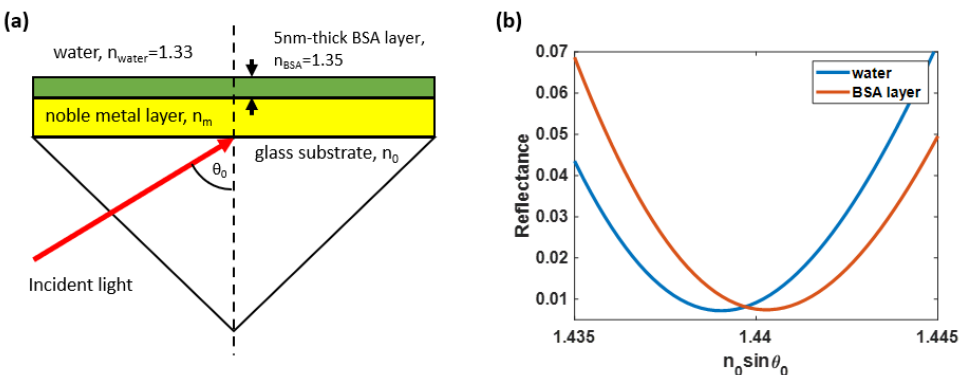
Figure 1. ( a ) The Kretschmann configuration consisting of a water-based sensing region, BSA binding layer, noble metallic film, a glass substrate, and incident light, and ( b ) the SPR sensor’s outputs consisting of reflectance curves, measuring from the water-based environment sensing region shown in the blue curve and a 5 nm-thick BSA coating layer in water shown in the red curve.